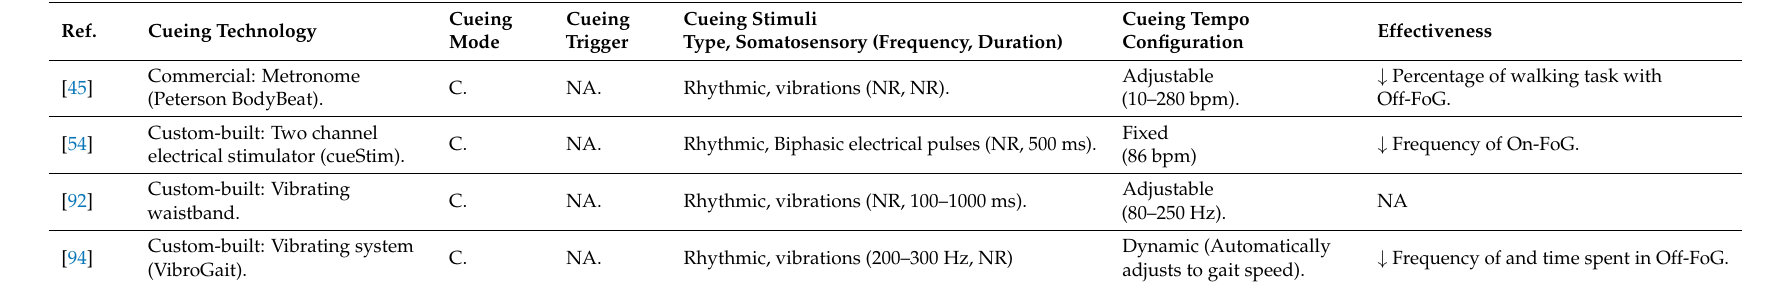
Table 4. Overview of somatosensory cueing